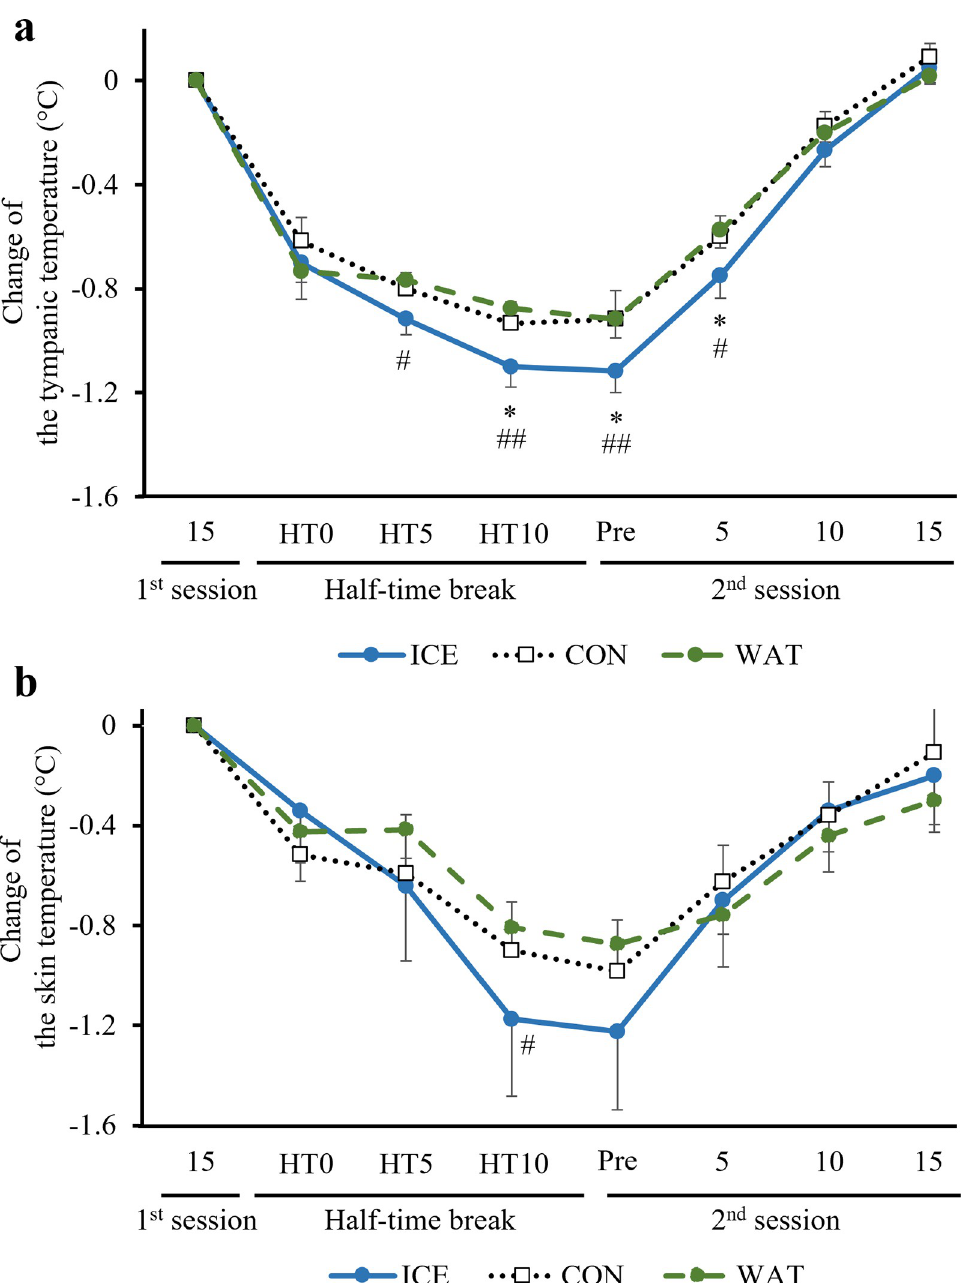
Fig 4. Temperature. ICE: − 2˚C-ice slurry; CON: 30˚C-beverage; WAT: 30˚C-water; HT0: start of the half-time break; HT5: 5 min after HT0; HT10: 10 min after HT0. The changes of the T ty (a) and T sk (b) from the 15 th sprint of the 1 st session to the half-time break and the 2 nd session in the ICE, CON, and WAT groups. Values are expressed as the means ± SE of the 12 participants. � p < 0.05 ICE vs. CON, #p < 0.05, ##p < 0.01 ICE vs. WAT. presented in S5 Table). The heat storage capacity during the 2 nd session (Pre to 15 th ) was sig- nificantly higher in the ICE group than that in the CON or WAT group (p = 0.047 vs. CON, p = 0.001 vs. WAT, Table 1). The change in the T was significantly greater in the ICE group sk than that in the WAT group at 10 min (p = 0.04 vs. WAT, Fig 4B; the raw data are presented in